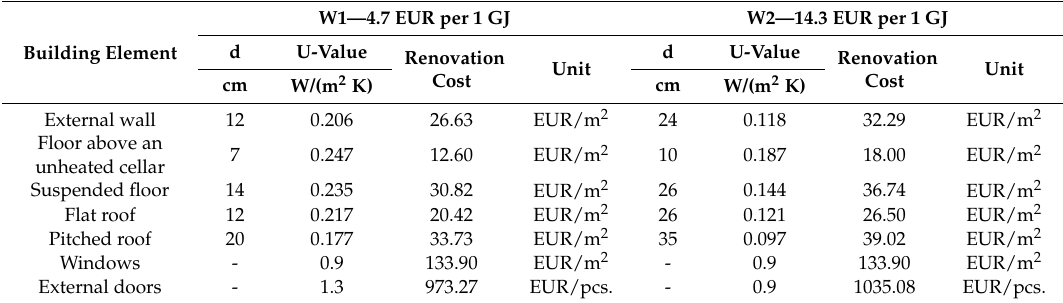
Table 12. The cost-optimum renovation variants (depending on the energy cost) of building’s envelope used in the stage II of the study (discount rate 4%).